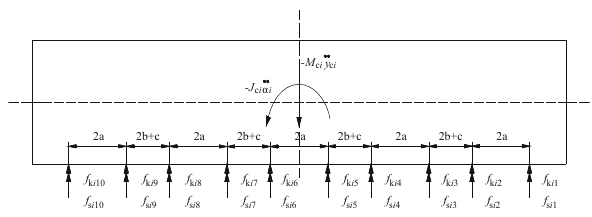
Fig. 2 Vertical model of vehicle